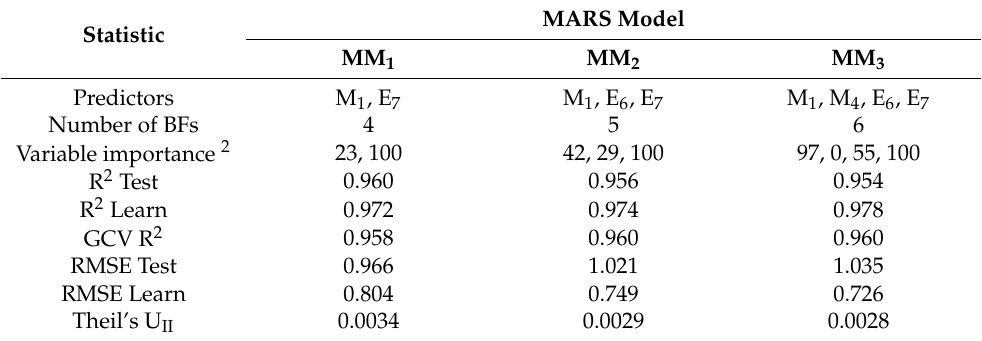
Table 6. Summary statistics of regression of MARS models built using CART and CART-EB models as predictors 1 .